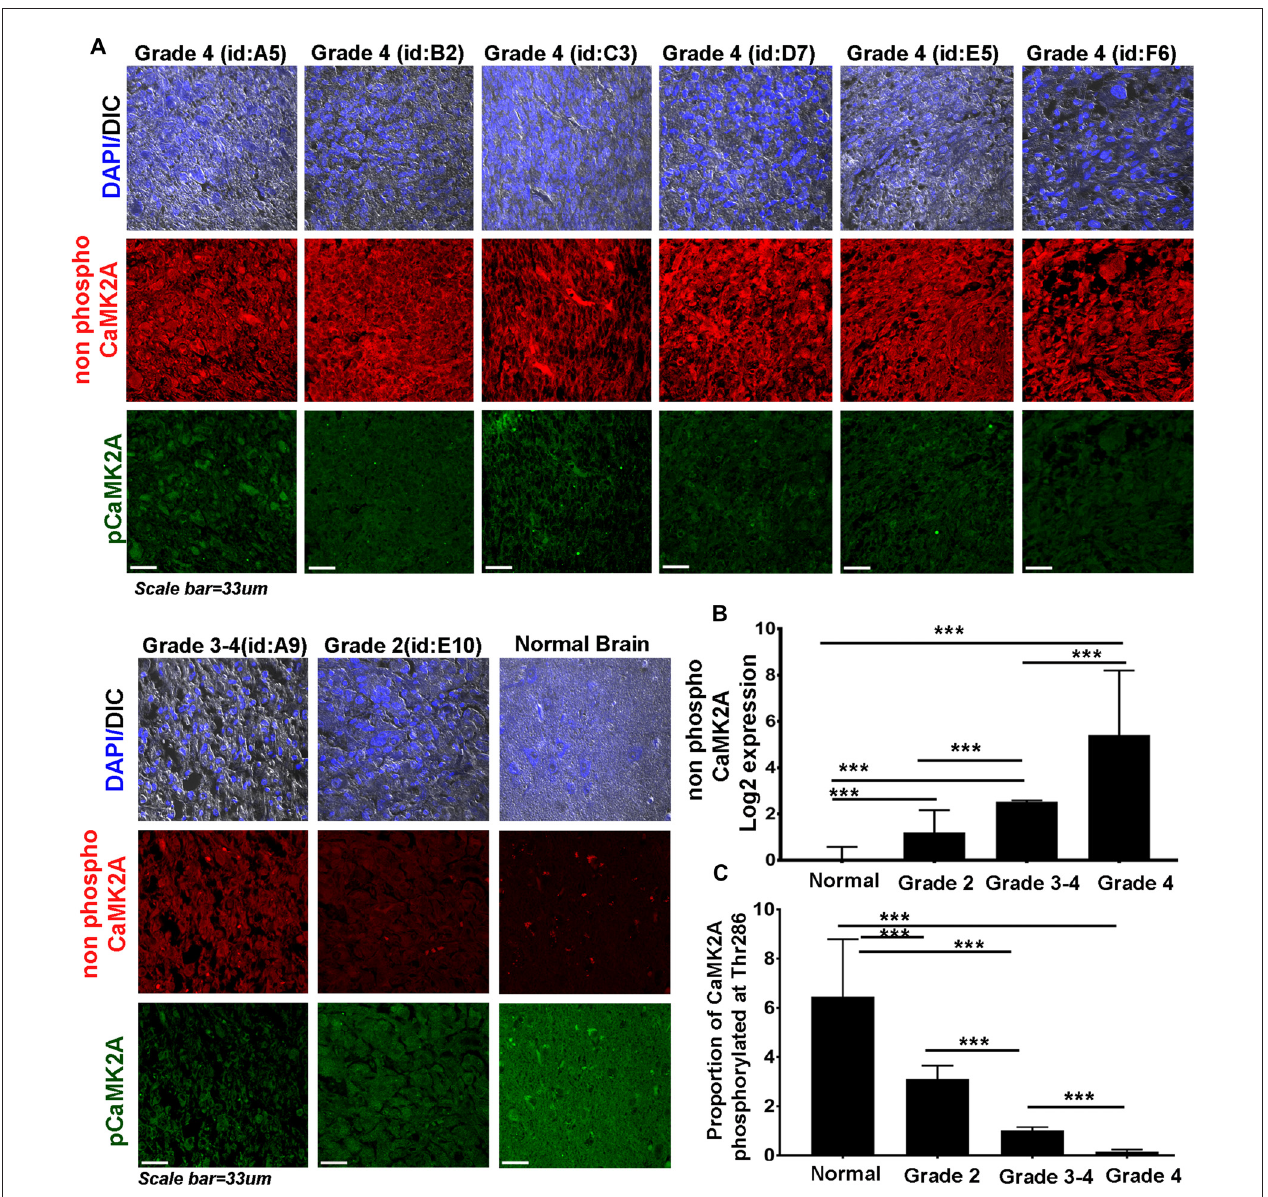
FIGURE 2 | CaMK2A phosphorylation at T286 is reduced in more advanced stages of GBM tumors. (A) Immunohistochemistry (IHC) based comparative and quantitative survey of the non-phosphorylated CaMK2A and its phosphorylation at T286 was performed using glioblastoma patient tissue array with 63 samples from WHO Grade IV (including four pediatric samples, Supplementary Figure S4), three samples from Grade III, four samples from Grade II and six normal controls. The identities of representative samples from each tumor grade as mentioned in the tissue array are specified. (B) Data shows that significantly higher levels of non-phosphorylated CaMK2A protein levels were associated with increase in GBM grade but (C) reverse trend was noticed for the proportion of CaMK2A phosphorylation at T286, which was determined by normalizing the levels of phospho-T286 to non phosphorylated CaMK2A. This suggests that phosphorylation of CaMK2A was tightly regulated in progressive GBM tumor grades and was crucially kept at lower levels. It is to be noted that normal brain samples expressed very high levels of phospho CaMK2A T286. ∗∗∗ p < 0.001. Error bar =